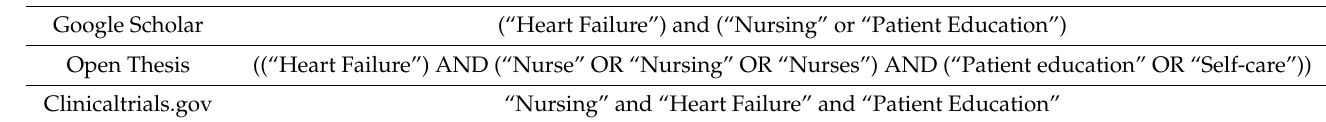
Table A2. Risk of bias assessment.